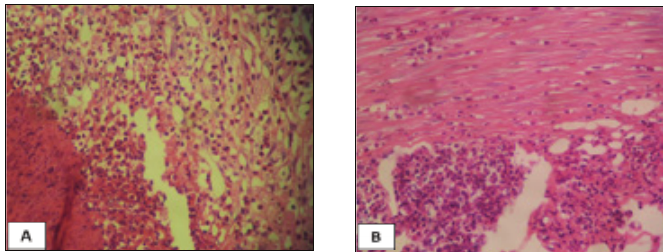
FIGURE 1 - Histological sections of the wall in the vermiform appendix showing exuberant neutrophilic infiltrate, edema and necrosis associated with mural specimen without inducing appendicitis, operated using the LigaSure TM ( A ), compared to specimens without inducing appendicitis operated using simple ligation ( B ) (HE, 400X).